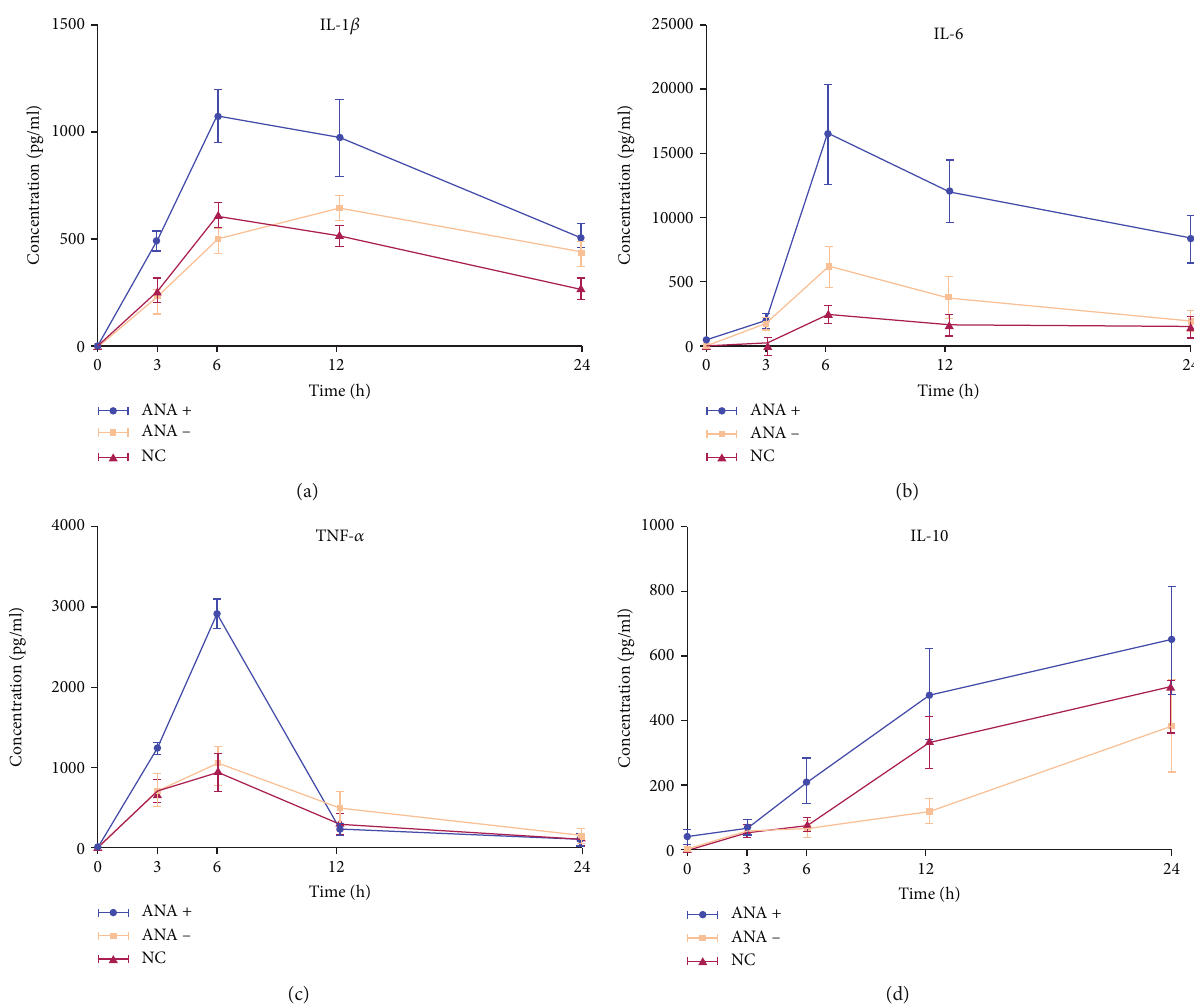
Figure 6: Changes in the cytokines in each group after LPS stimulation. Six hours after stimulation, IL-1 β , IL-6, and TNF- α reached their peaks and then decreased. Within 24h, IL-10 showed an upward